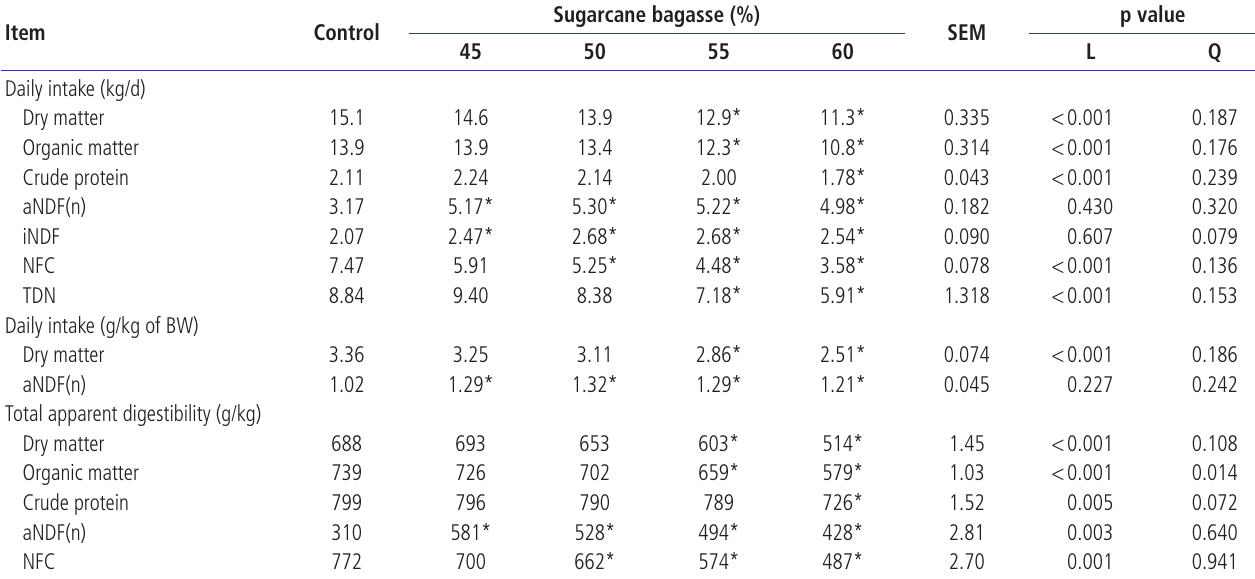
Table 3. Nutrient intake and apparent digestibility in cows fed sugarcane